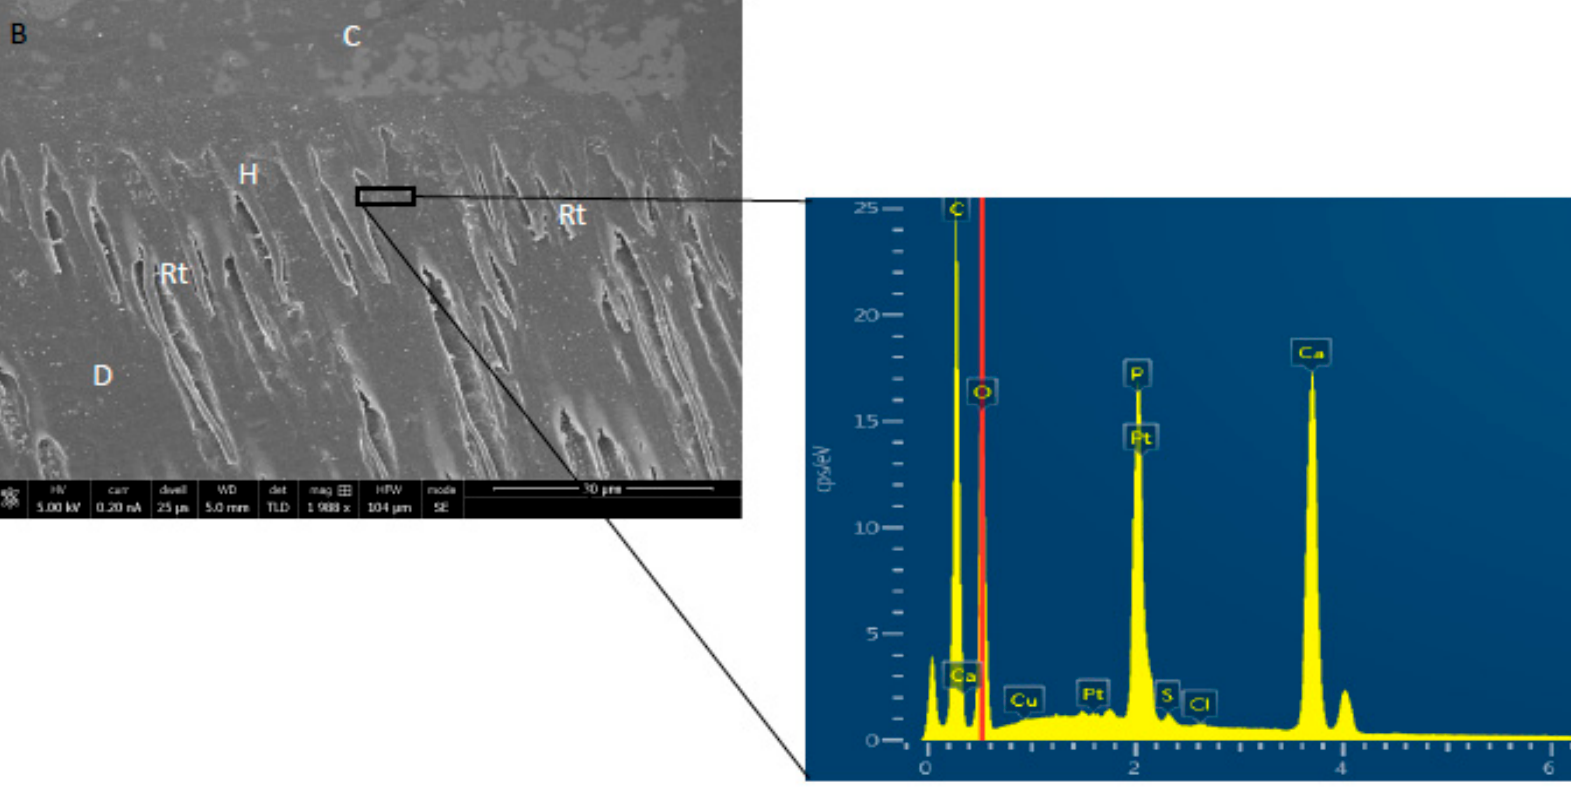
Figure 3. Resin-dentin bonded interface for ( A ) HA-GO-2.0% and ( B ) control showing excellent bonding between composite and dentin structure. EDX spectrum for HA-GO-2.0% specimen showing highest percentage of carbon (63.3%) followed by Calcium (10.8%) within the hybrid layer, reflecting the existence of graphene and HA nanoparticles. The control specimen containing highest percentage of calcium (70%) and phosphorus (30%) within the resin matrix. C = composite; H = hybrid layer; Rt = resin tags; D = dentin